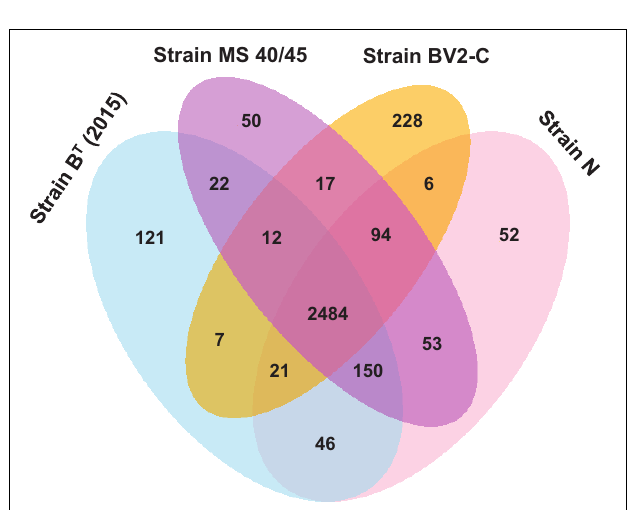
FIGURE 6 | Venn diagram showing the distribution of core, accessory and unique genes shared between the genomes of C. thermophilum strain B T (2015), C. aggregatum strain N, C. aggregatum strain MS40/45, and C. validum strain BV2-C. This analysis includes most of the genes found in the pangenome for all Chloracidobacterium spp. strains described in this